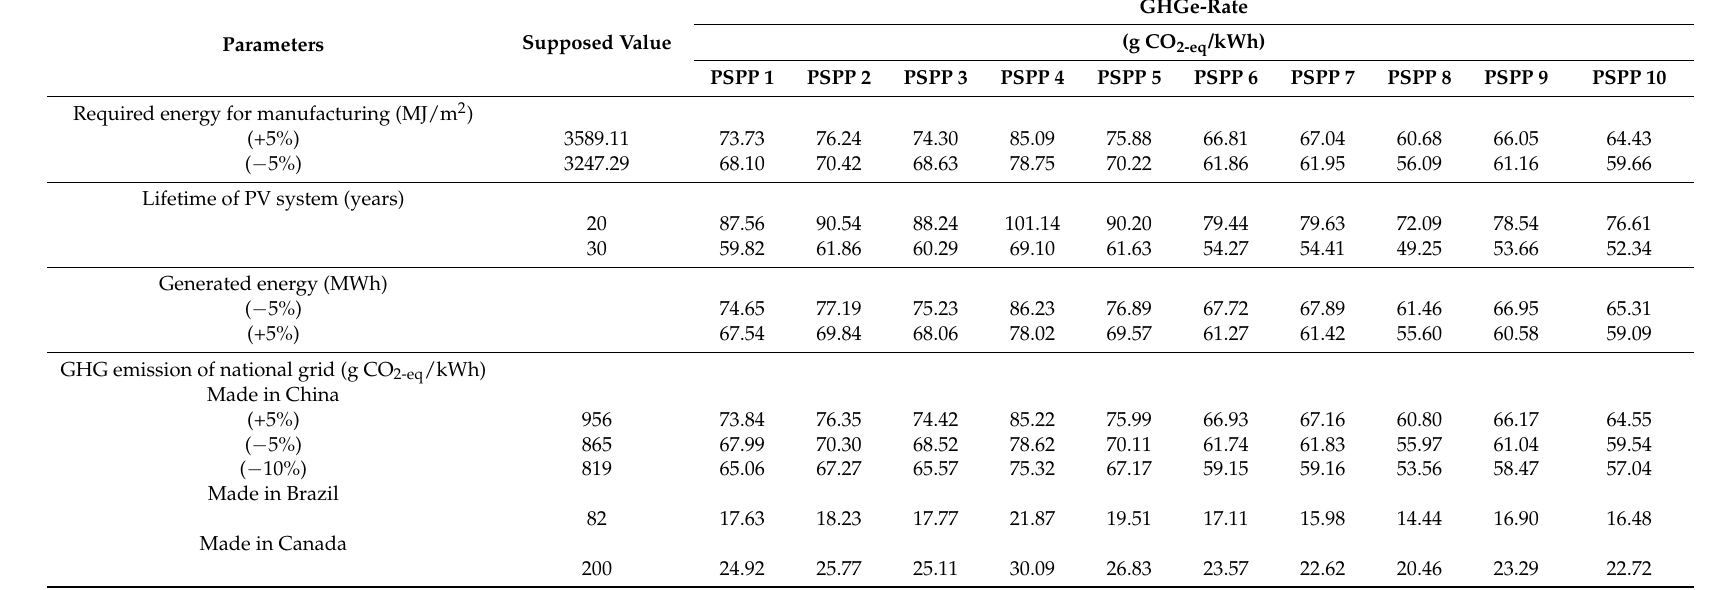
Table 10. Sensitivity analysis for key PVSS parameters with Multi-Si